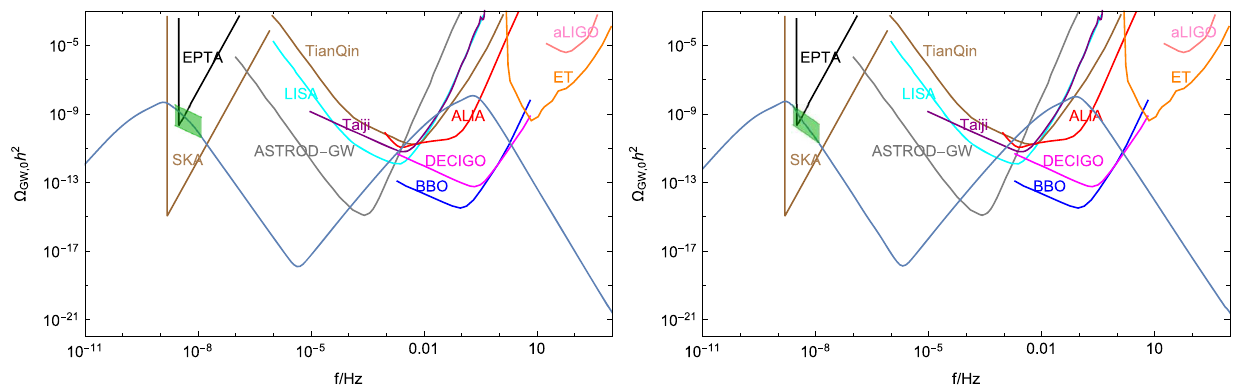
Fig. 5 Energy spectrum of the induced GWs at the present time pre- dicted by Model I for parameter set (20) (left panel), and by Model II for parameter set (23) (right panel). The curves in the upper part are the expectedsensitivitycurvesoftheSquareKilometerArray(SKA),Euro- pean Pulsar Timing Array (EPTA), Astrodynamical Space Test of Rela- tivityusingOptical-GWdetector(ASTROD-GW), Taiji,LaserInterfer- ometer Space Antenna (LISA), TianQin, Advanced Laser Interferome-